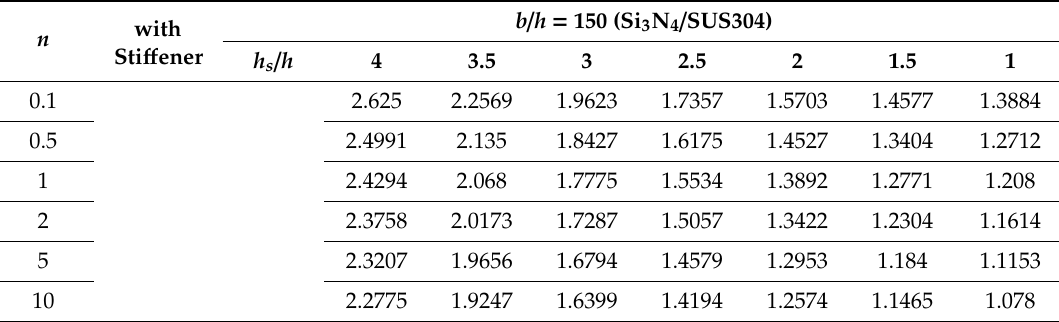
Table 7. Buckling coe ffi cient of FGM plate with and without a central sti ff ener (Si3N4 / SUS304, b / h = 150).